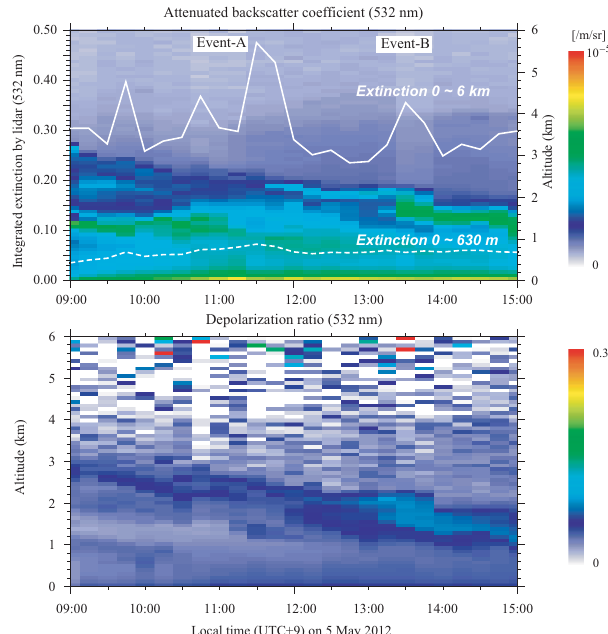
Figure 8. Estimated aerosol optical thickness and attenuated backscatter coefficient (top panel) and depolarization ratio (bottom panel) at 532nm by AD-Net lidar at the AERONET Osaka site on 5 May 2012. Solid and dashed lines in the upper panel represent the AOT from the lidar site up to 6km and that from the site to up to